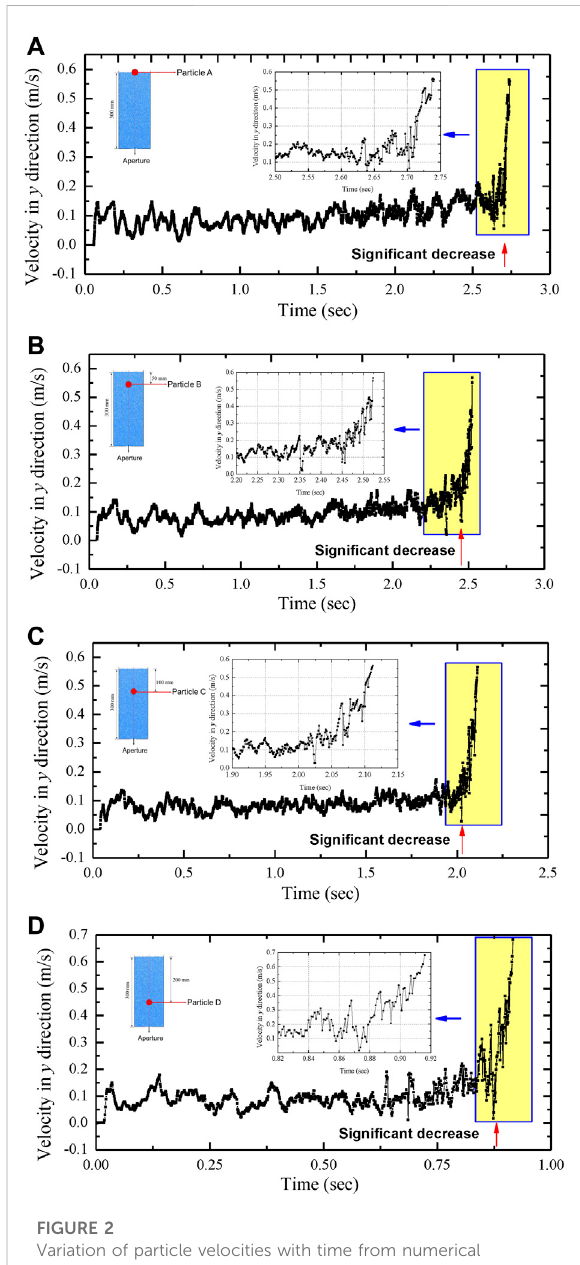
FIGURE 2 Variation of particle velocities with time from numerical simulations: (A) particle A ; (B) particle B ; (C) particle C ; (D) particle